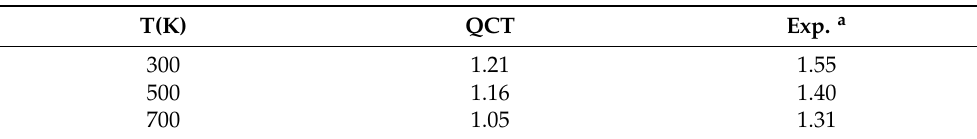
Table 5. QCT/PES-2020 and experimental ratios for CN (v = 1)/CN (v = 0). Reactivity at different